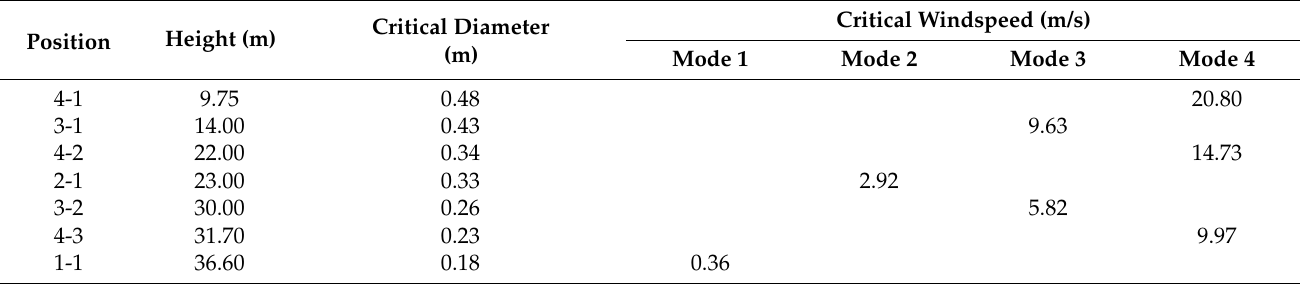
Table 2. Critical Windspeed.